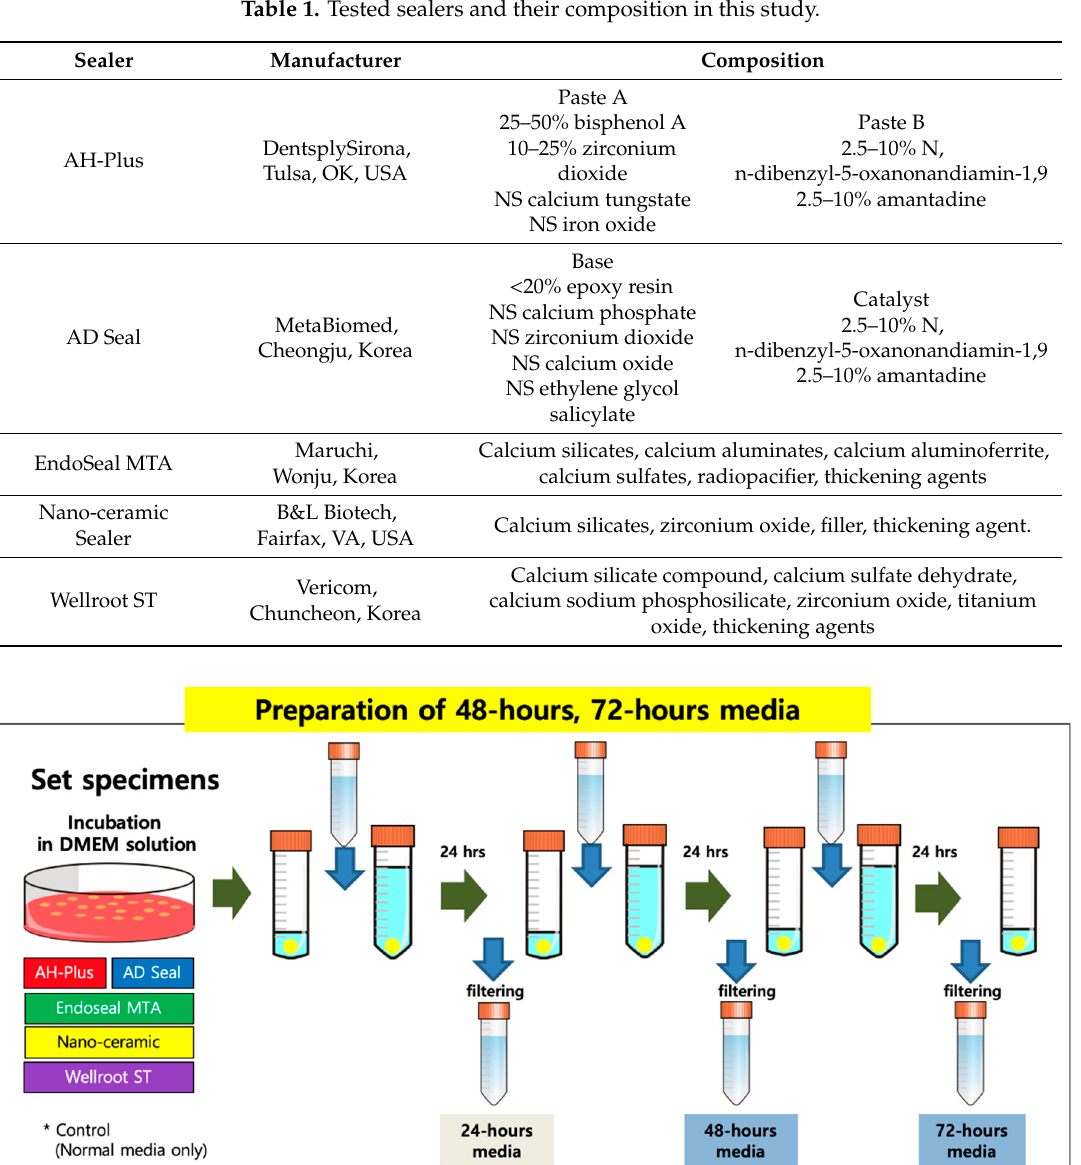
Table 1. Tested sealers and their composition in this study.